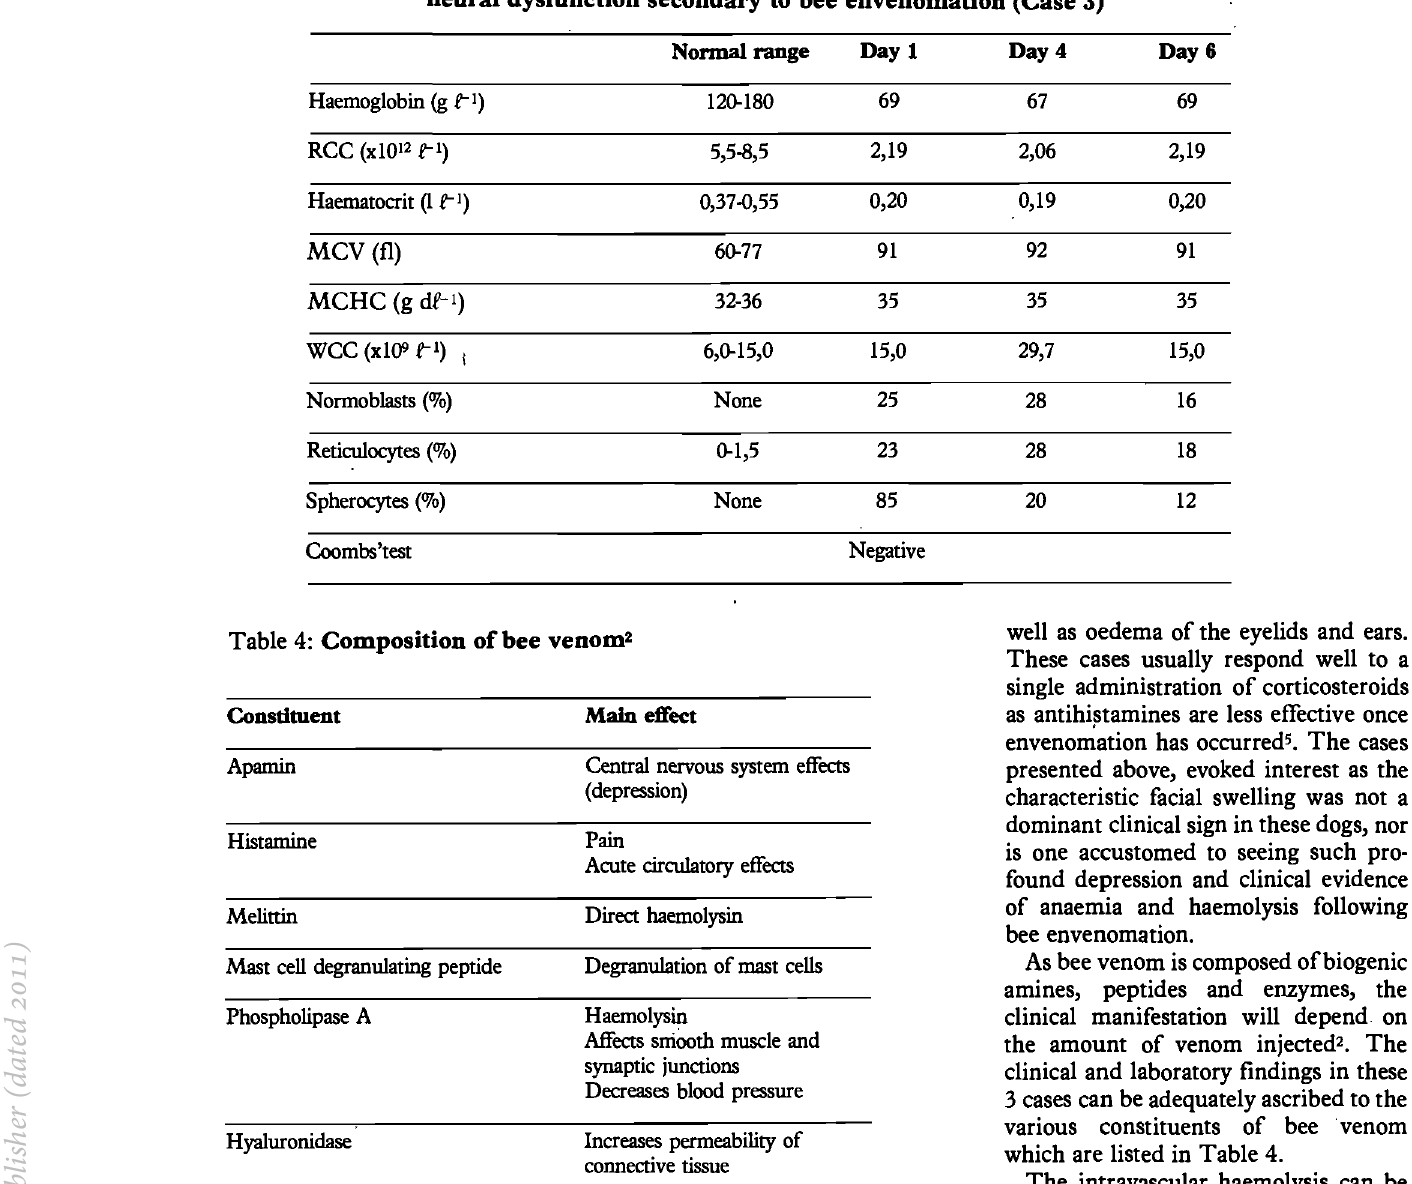
Table 3: Haematological parameters of a Pomeranian with spherocytosis and